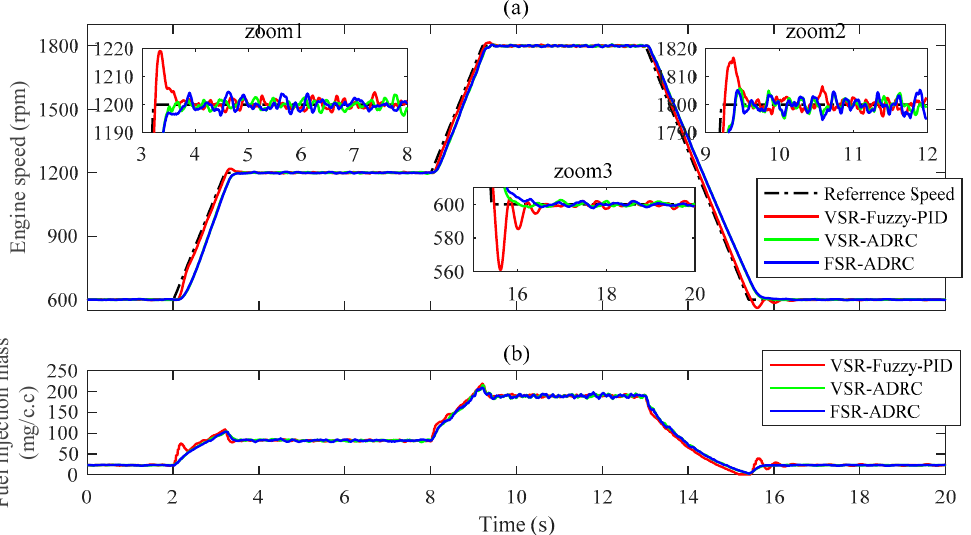
Figure 7. The control performance comparison of different controllers during the speed tracking mode under standard engine model: ( a ) The speed response; ( b ) the control input.